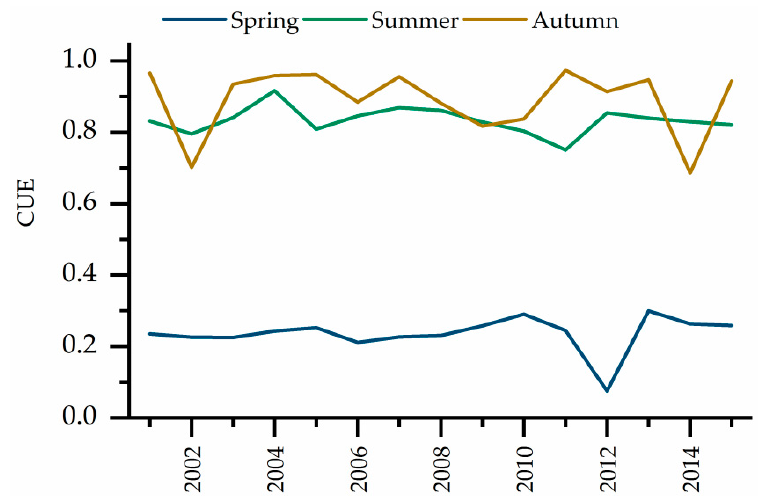
Figure 5. Average CUE variations in spring, summer and autumn from 2001 to 2015.